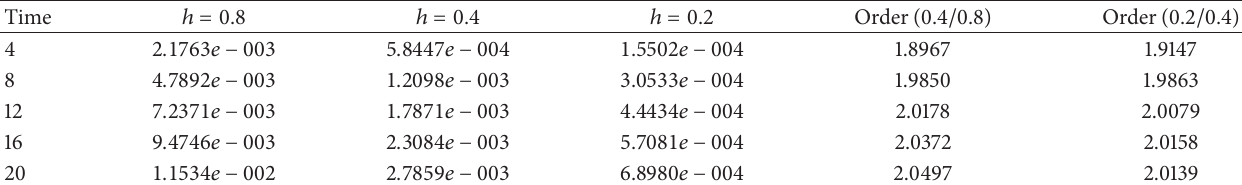
Table 7: Convergence order and error in 𝐿 ∞ norm for 𝑢 of space with Δ𝑡 = 0.01 and 𝑐 = 0.1 .